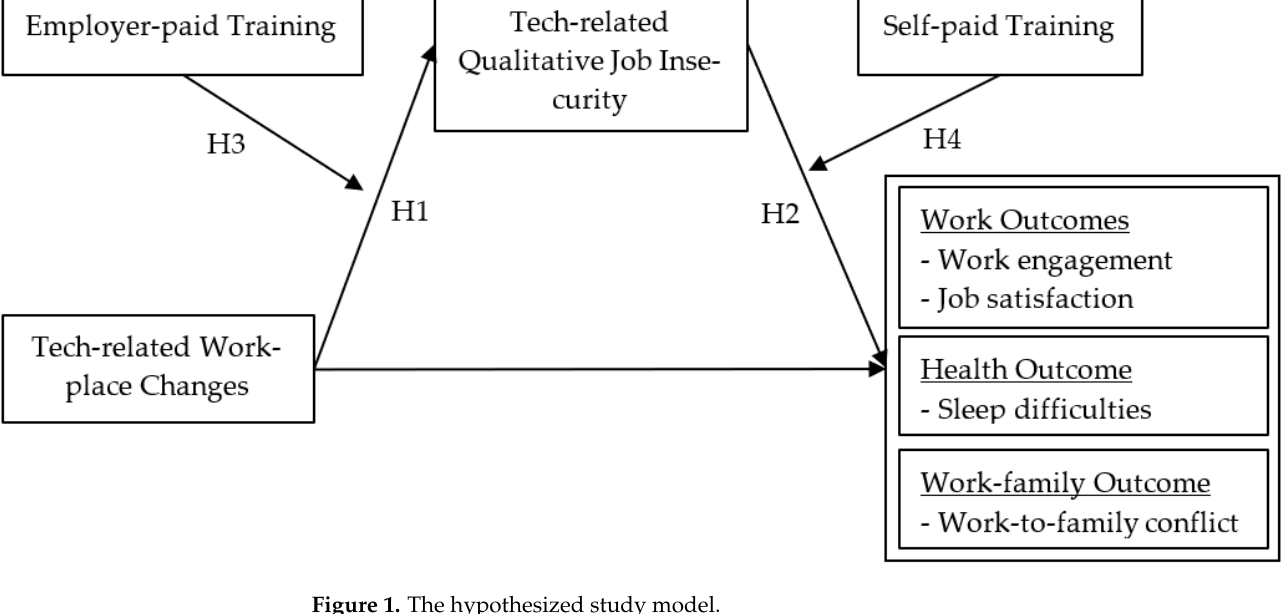
Figure 1. The hypothesized study